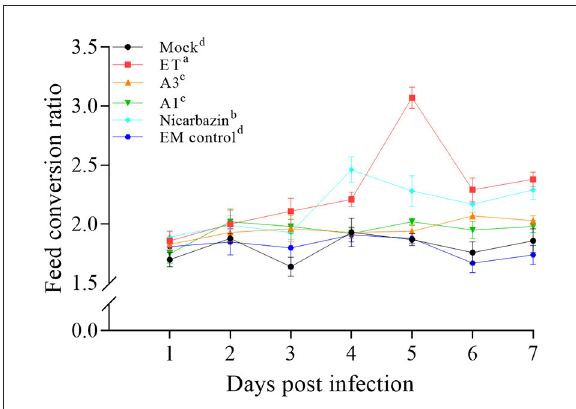
FIGURE6 Evaluation of the chicken SR in vivo from Day 1–7 p.i. A3 and A1 represent EM treatment 3 days before and 1 day after ET infection, respectively. EM, extract and essential oil mixture (non-toxic concentrations of Punica granatum L., Plantago asiatica L., Bidens pilosa L., Acalypha australis L., Pteris multifida Poir, and Portulaca oleracea L. sp. Pl. extracts and Artemisia